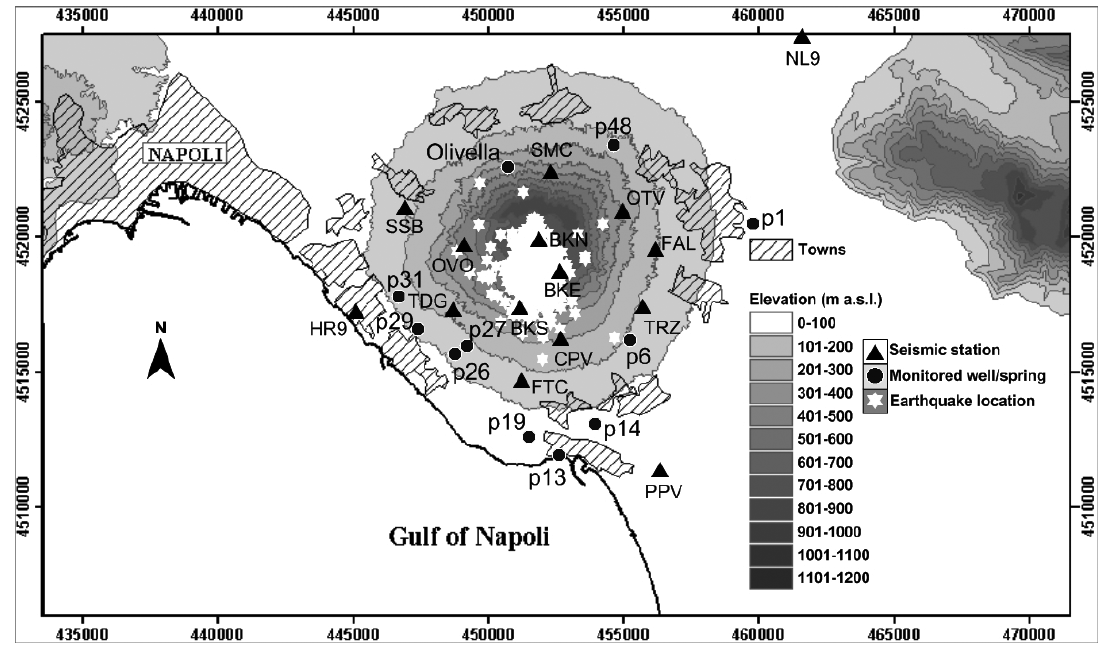
Figure 1. Map of the Mt. Vesuvius area showing the locations of earthquakes and measuring points of the seismic and geochemical sur- veillance